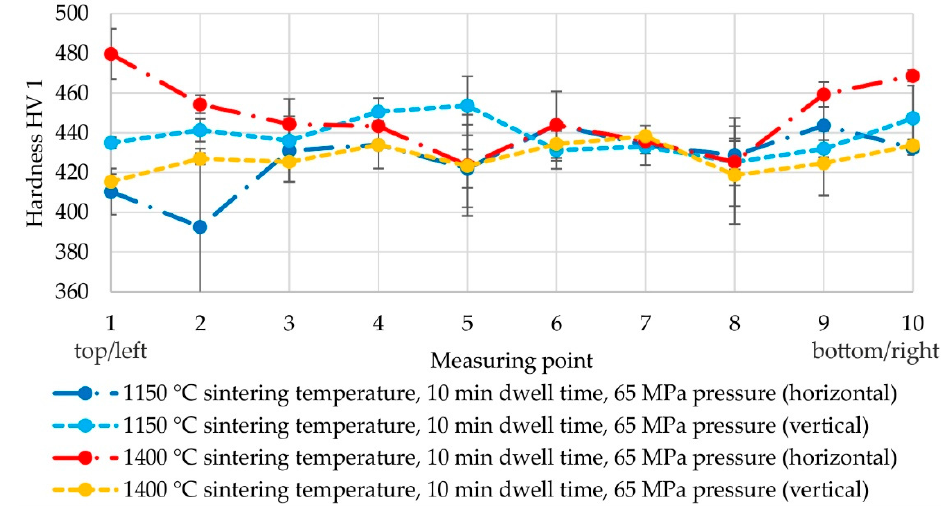
Figure 15. Hardness profiles in vertical and horizontal direction from top or left to bottom or right of samples of TNM, sintered at 1150 °C and 1400 °C.